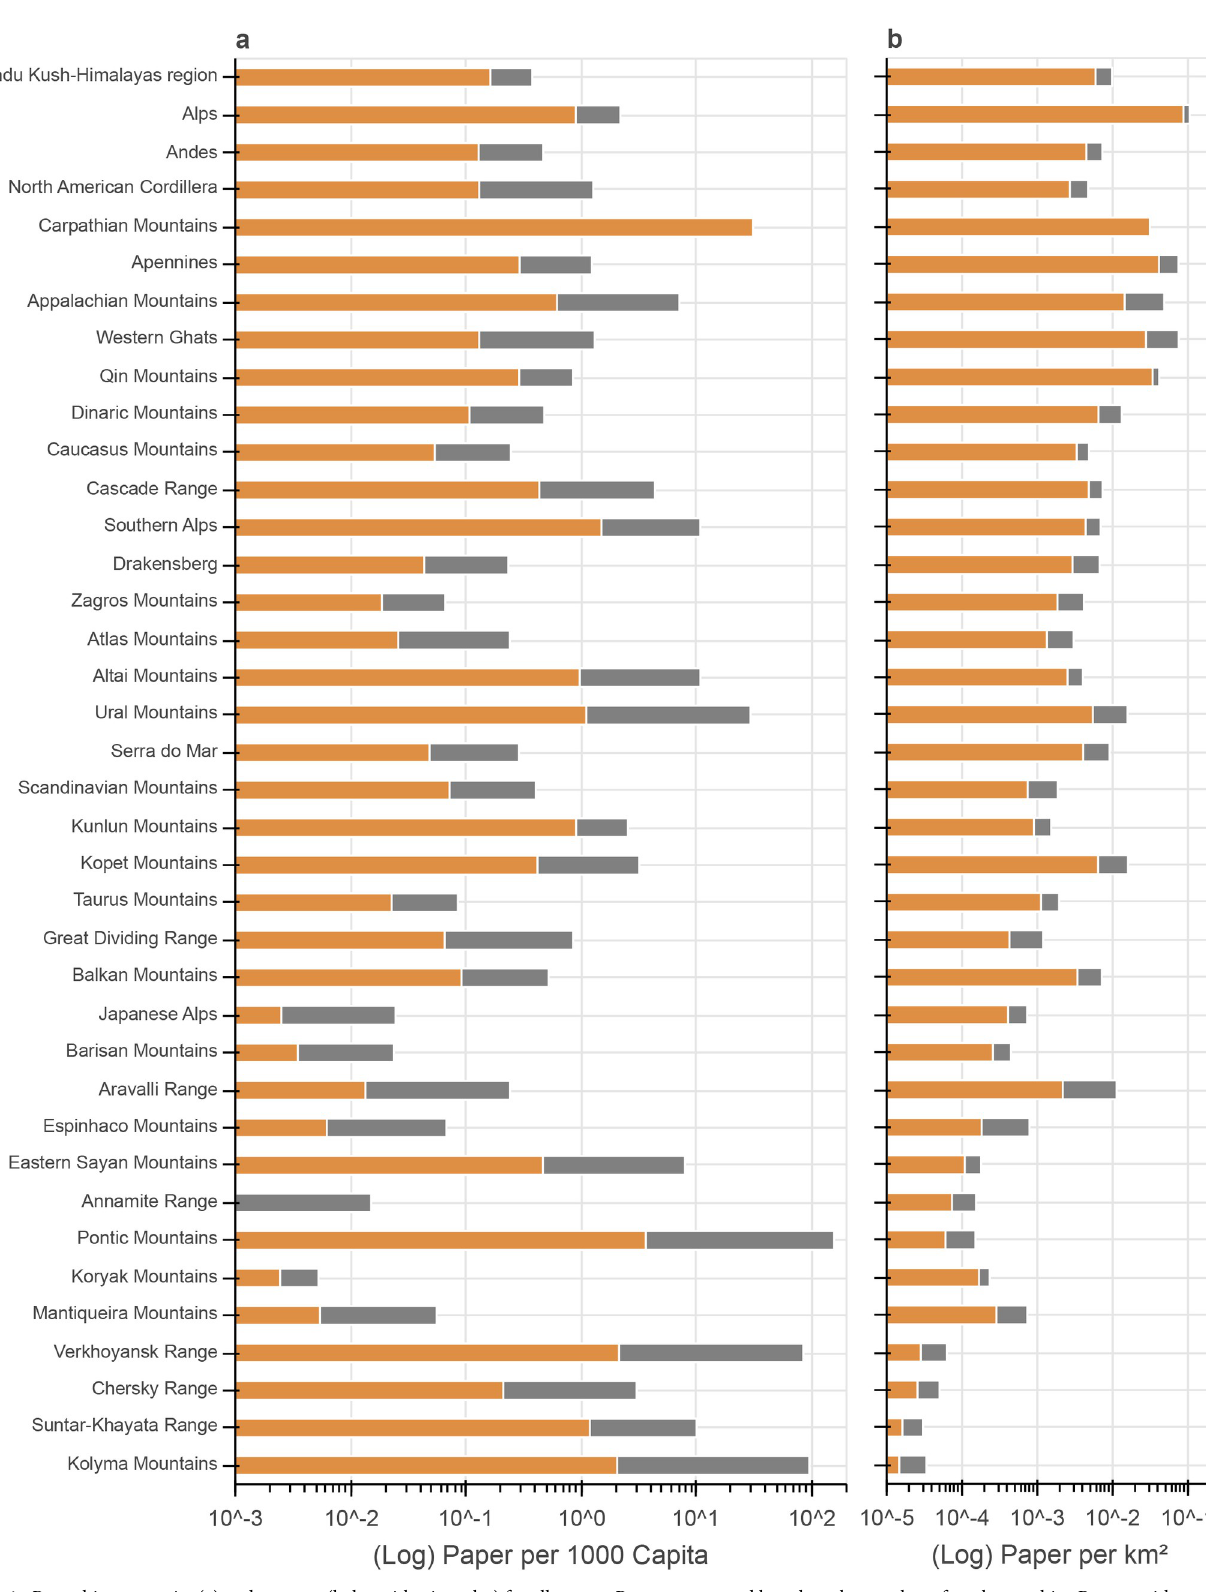
Fig 4. Paper hits per capita (a) and per area (b; logarithmic scales) for all ranges. Ranges are sorted based on the number of total paper hits. Ranges with no hits are not shown. Orange refers to the polygon area, orange plus grey to the mountainous area (see methods). Capita data represent 2019 values.